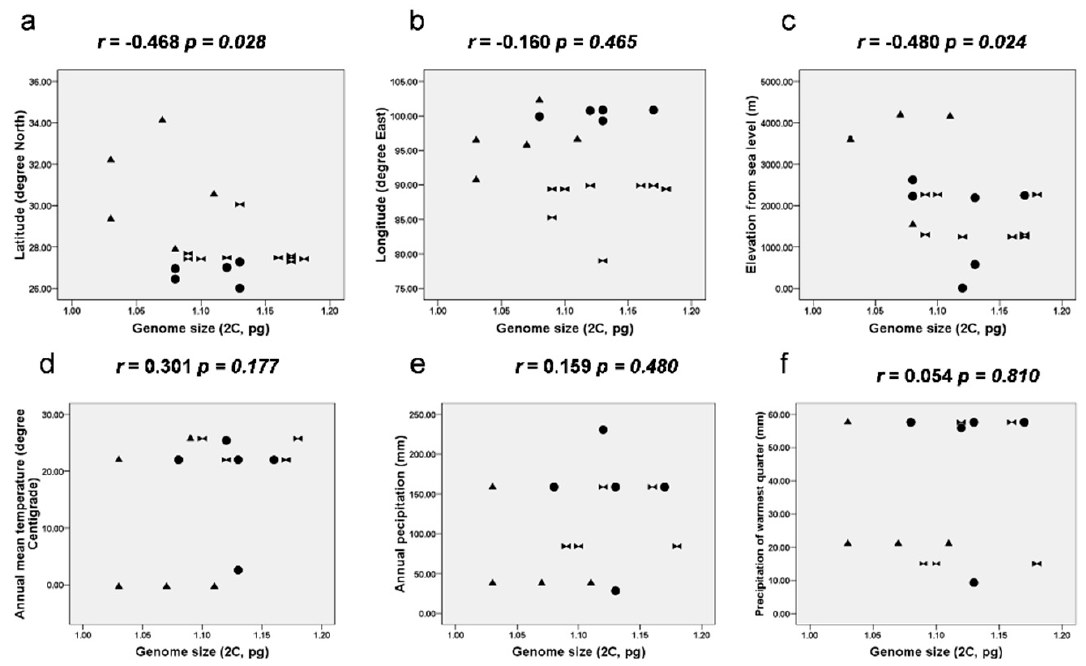
Figure 5. Correlation of genome size with environmental variables showing genome size is unaffected by environmental variables apart from latitude and altitude. The scatter plot shows correlations of ( a ) genome size with latitude, ( b ) genome size with longitude, ( c ) genome size with altitude, ( d ) genome size with annual mean temperature, ( e ) genome size with annual precipitation, and ( f ) genome size with precipitation of warmest quarter. The filled circles represent landraces from Hengduanshan, filled triangles represent landraces from Qinghai Tibetan Plateau, and the filled dumbbell shapes represent landraces from the